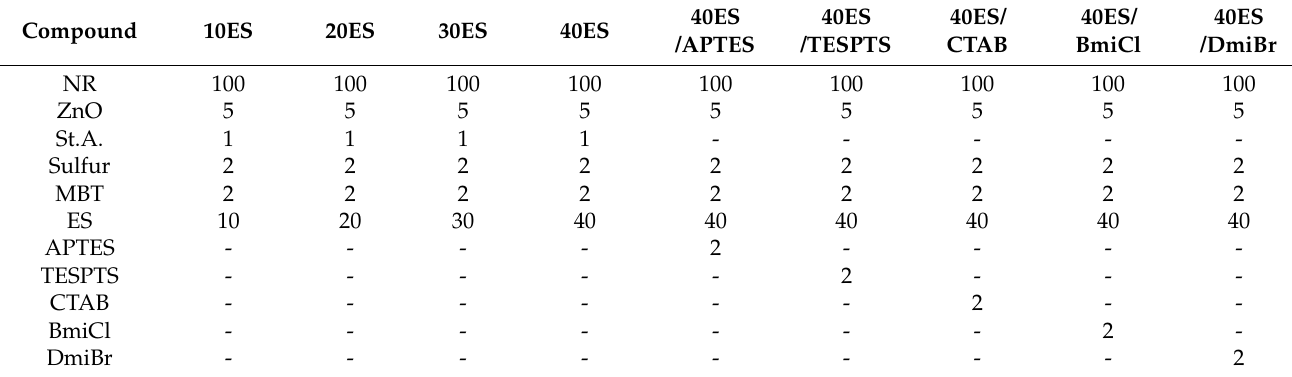
Table 2. General recipes of the eggshells-filled NR compounds used in this study; phr, parts per hundred of